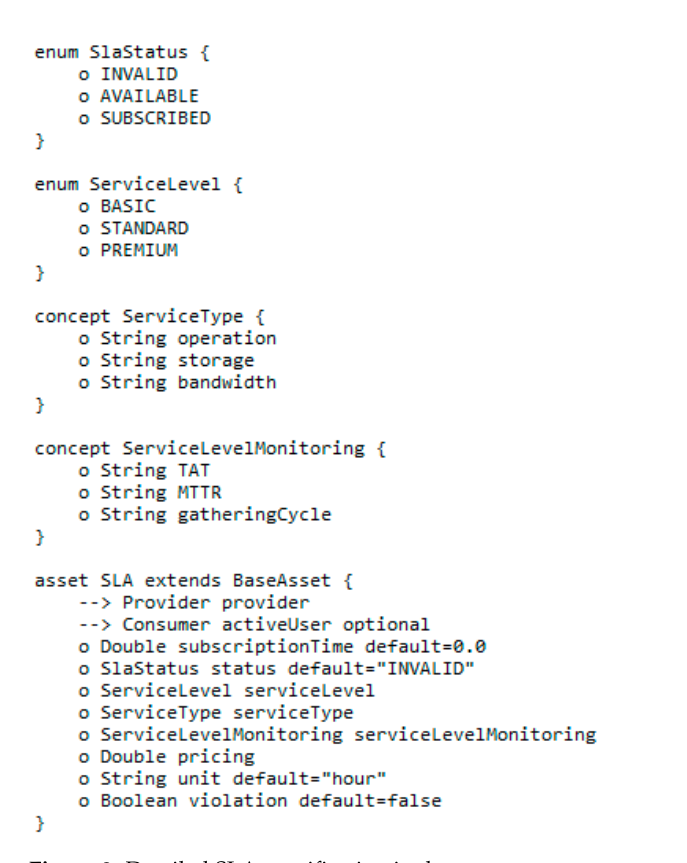
Figure 8. Detailed SLA specification in the smart contract.